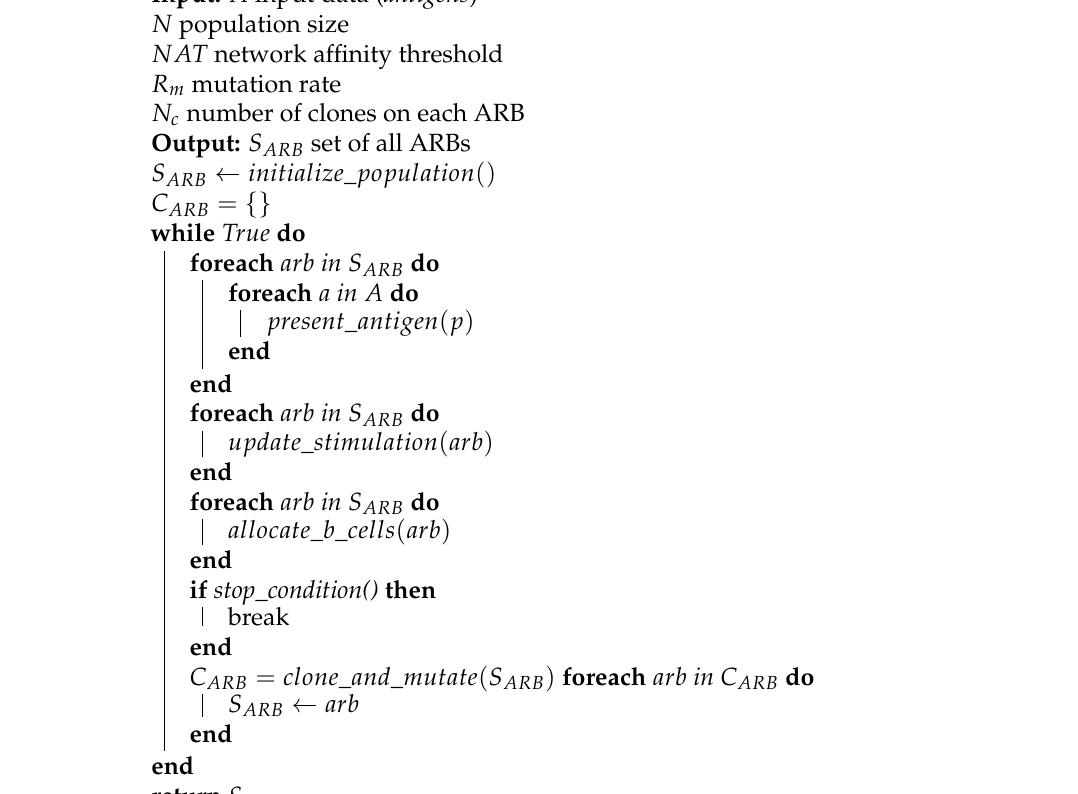
Algorithm 3: A specific Artificial Immune Network (AIN) implementation for generating an B cells cluster population, based on Artificial Immune Network (AINE) algorithm